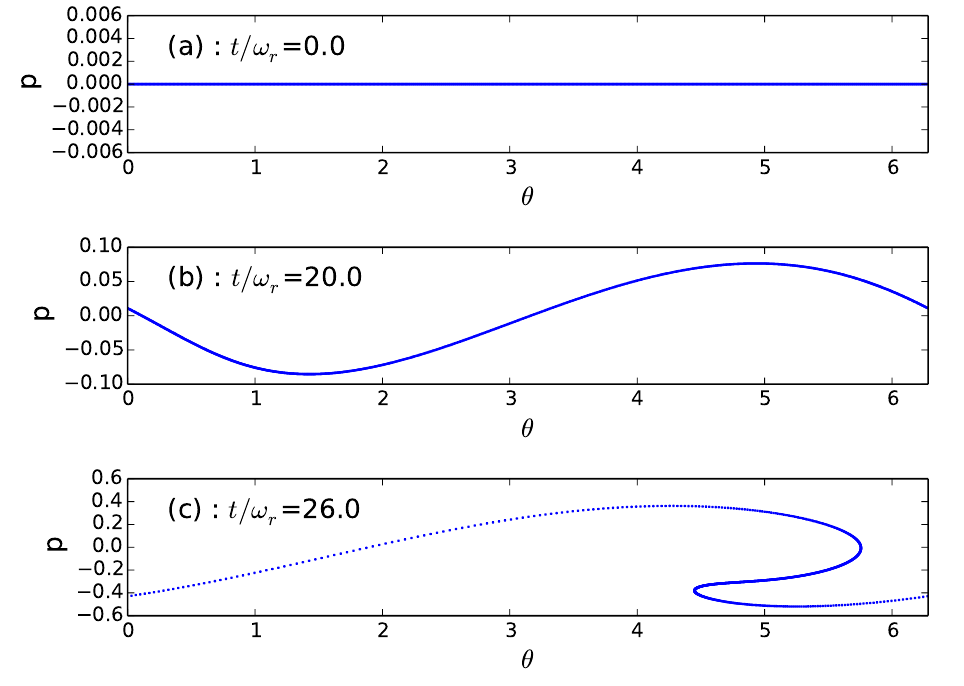
, p ) for each atom j = 1 .. 1000 when ( a ) j j in the case of weak excitation. The parameters r